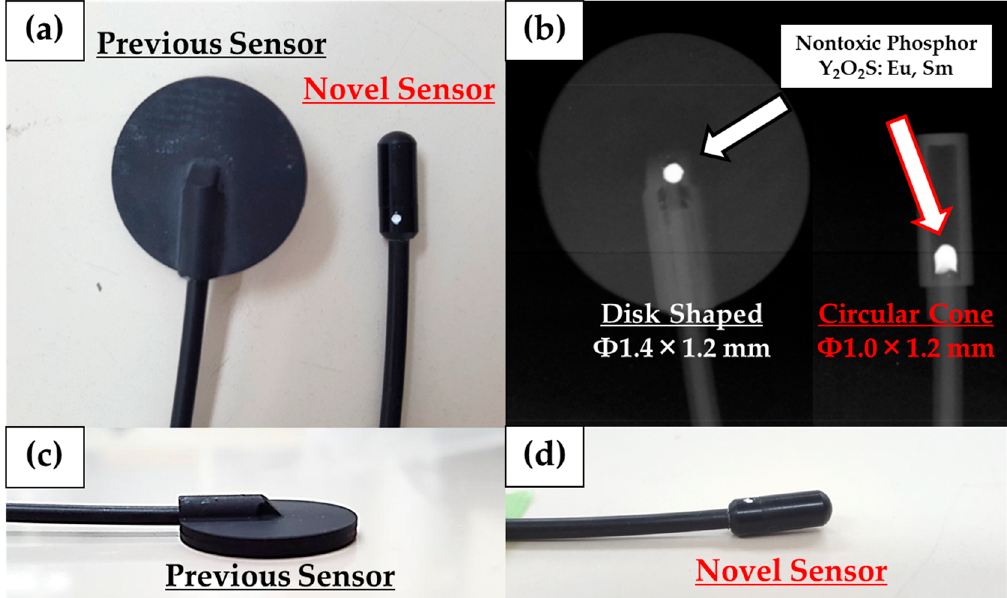
Figure 1. Novel and previous sensors: ( a ) top view, ( b ) X-ray image, ( c , d ) lateral view. By changing the phosphor from a disk to cone shape, the novel dosimeter can provide better angular sensitivity.